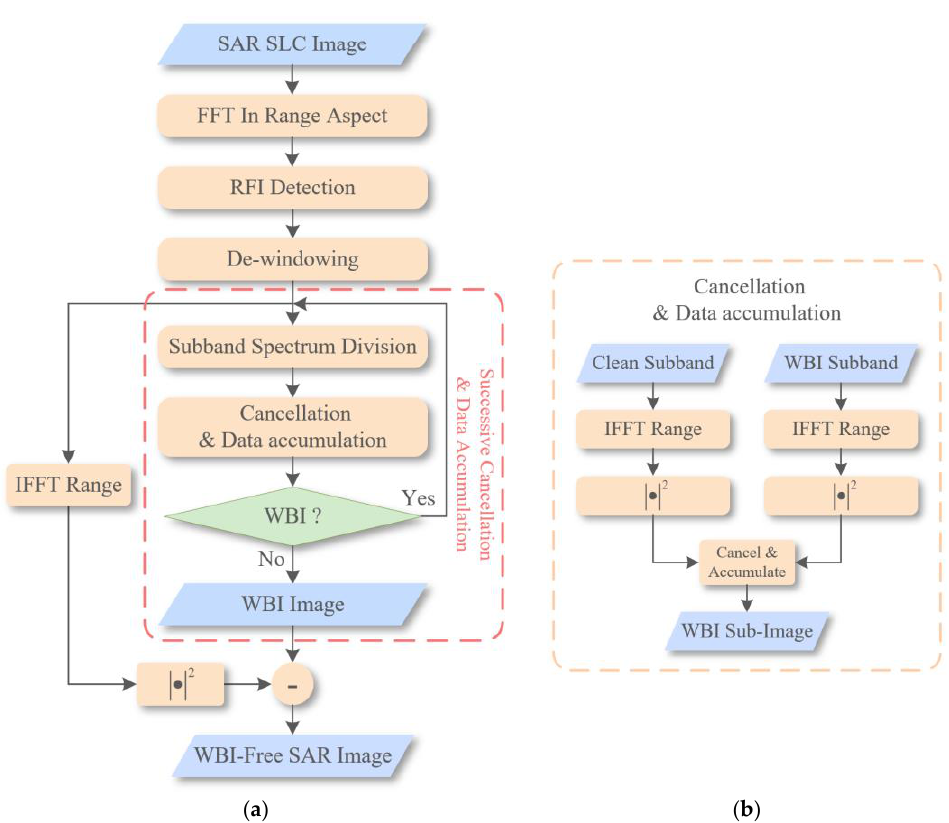
Figure 5. T he flow chart of the proposed method. ( a ) T he flow chart of the improved SSC method. Figure 5. The flow chart of the proposed method. ( a ) The flow chart of the improved SSC method. ( b ) The flow chart of the cancellation and data accumulation is in Figure 5a. ( b ) The flow chart of the cancellation and data accumulation is in Figure